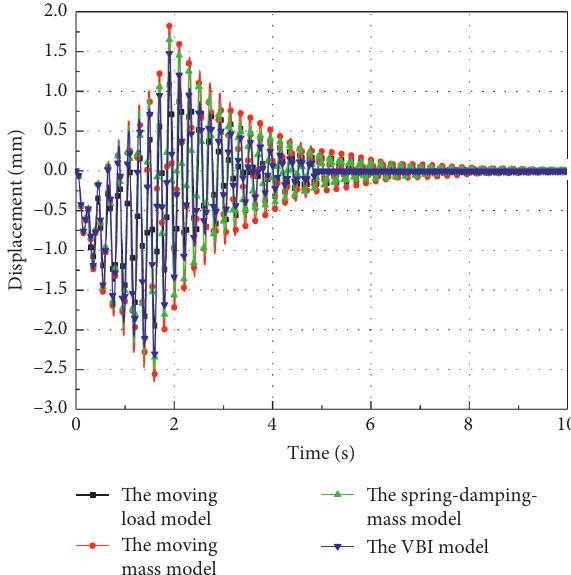
Figure 8: The maximum displacement of the bridge under the four models at different speeds.